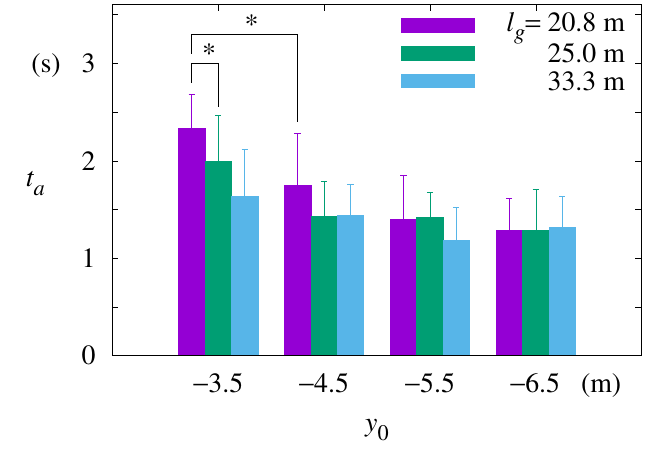
Figure 4. Distributions of parameter t a for varying y 0 and l g . Here, v c = 30 km/h and vehicle type is sedan. Columns indicate the average values of t a in the data for given experimental conditions while error bars represent standard deviations. Pairs of samples, marked with asterisks, are presumed to belong to different distributions ( p < 0.05) according to the Mann-Whitney U test. (Note here that not all such pairs are marked.)